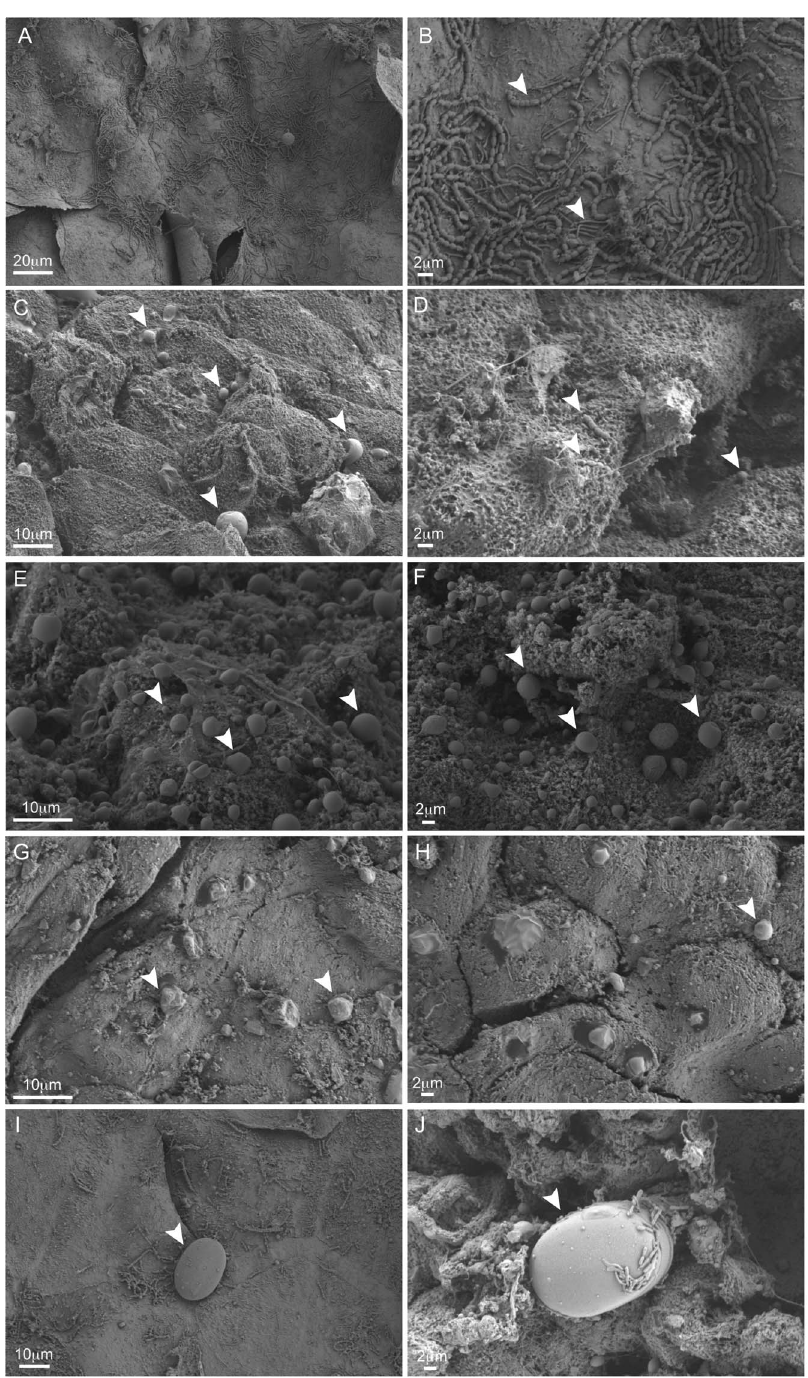
Figure 8. Scanning electron micrographs of whale skin-bacteria. Overview (A, C, E, G) and detailed (B, D, F, H) scanning electron micrographs of the surface of humpback whale skin from individuals CCS2010-100 (A, B), CCS2010-99 (C,D), CCS2010-96 (E,F) and CCS2010-98 (G,H). Diatoms, and microbes residing on these cells, were present on the surfaces of CCS2010-100 (I) and CCS2010-97 (J). Arrows indicate possible unique microbial cell